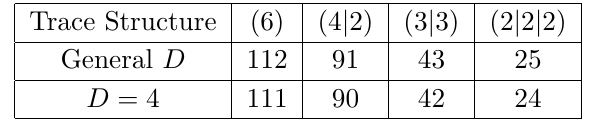
Table 6 . Number of independent 6-pt amplitudes/operators at O ( p 10 ) for each trace structure in general spacetime dimensions D (given in [16]) and specifically in D = 4 .